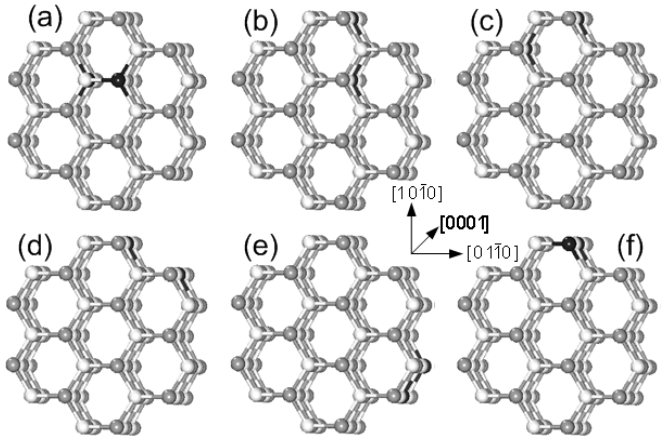
Figure 2. The structures of Mn-doped ZnO NWs. ( a ) Configuration I; ( b ) Configuration II; ( c ) Configuration III; ( d ) Configuration IV; ( e ) Configuration V; ( f ) Configuration VI. (The white, gray, and black spheres represent O, Zn, and Mn atoms,